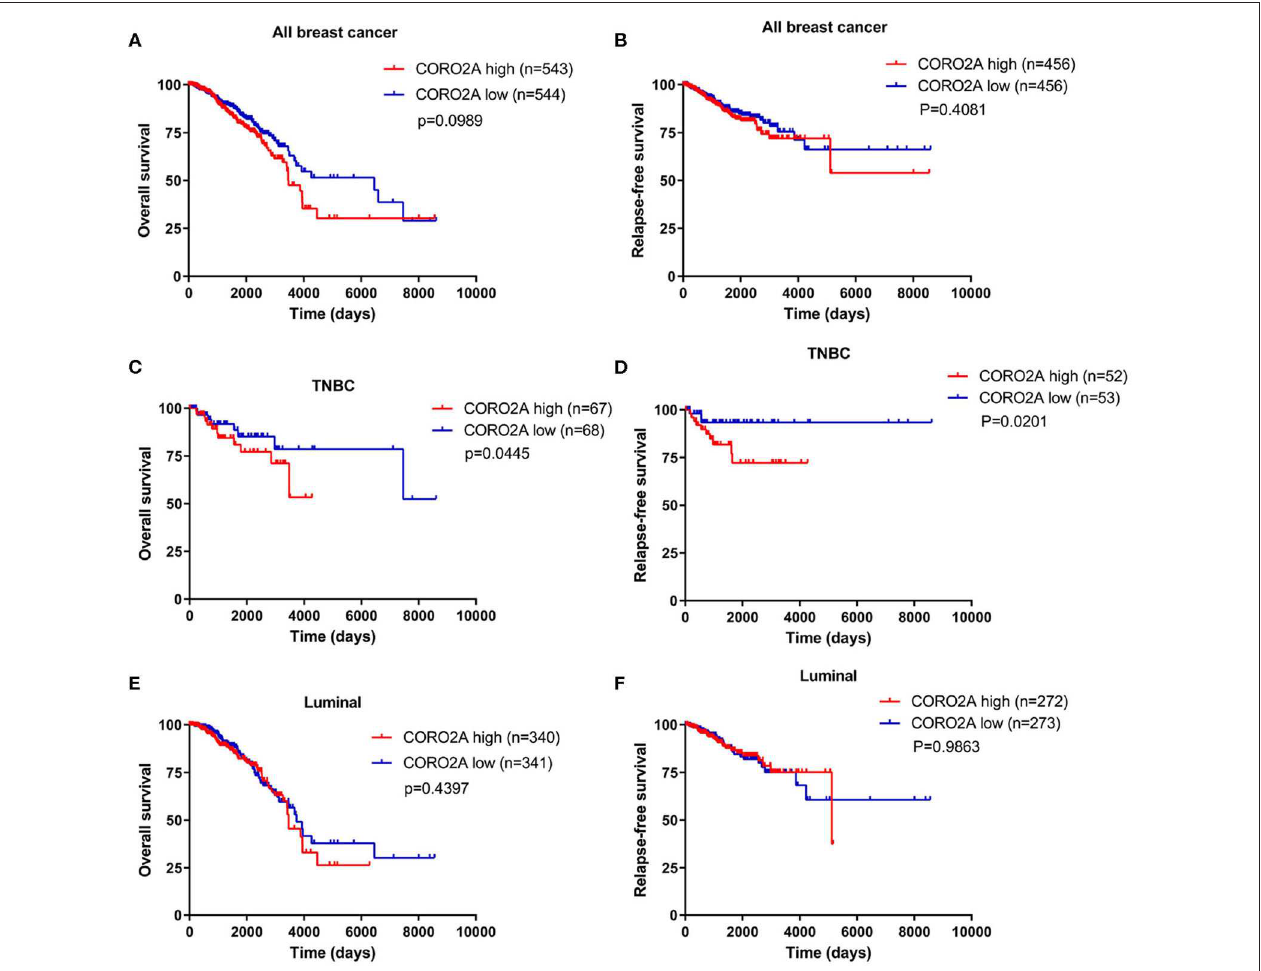
FIGURE 2 | Kaplan–Meier survival analysis of breast cancer patients based on CORO2A expression level. (A) Comparison of overall survival (OS) between patients with CORO2A high and low expression levels in 1,087 breast cancer patients. (B) Comparison of relapse free survival (RFS) between patients with CORO2A high and low expression levels in 912 breast cancer patients. (C) Comparison of overall survival (OS) between patients with CORO2A high and low expression levels in 135 TNBC patients. (D) Comparison of relapse free survival (RFS) between patients with CORO2A high and low expression levels in 105 TNBC patients. (E) Comparison of overall survival (OS) between patients with CORO2A high and low expression levels in 681 luminal breast cancer patients. (F) Comparison of relapse free survival (RFS) between patients with CORO2A high and low expression levels in 545 luminal breast cancer patients. The samples with absent relapse free survival (RFS) time are removed in advance, when comparing the relapse free survival (RFS) between patients with CORO2A high and low expression levels.